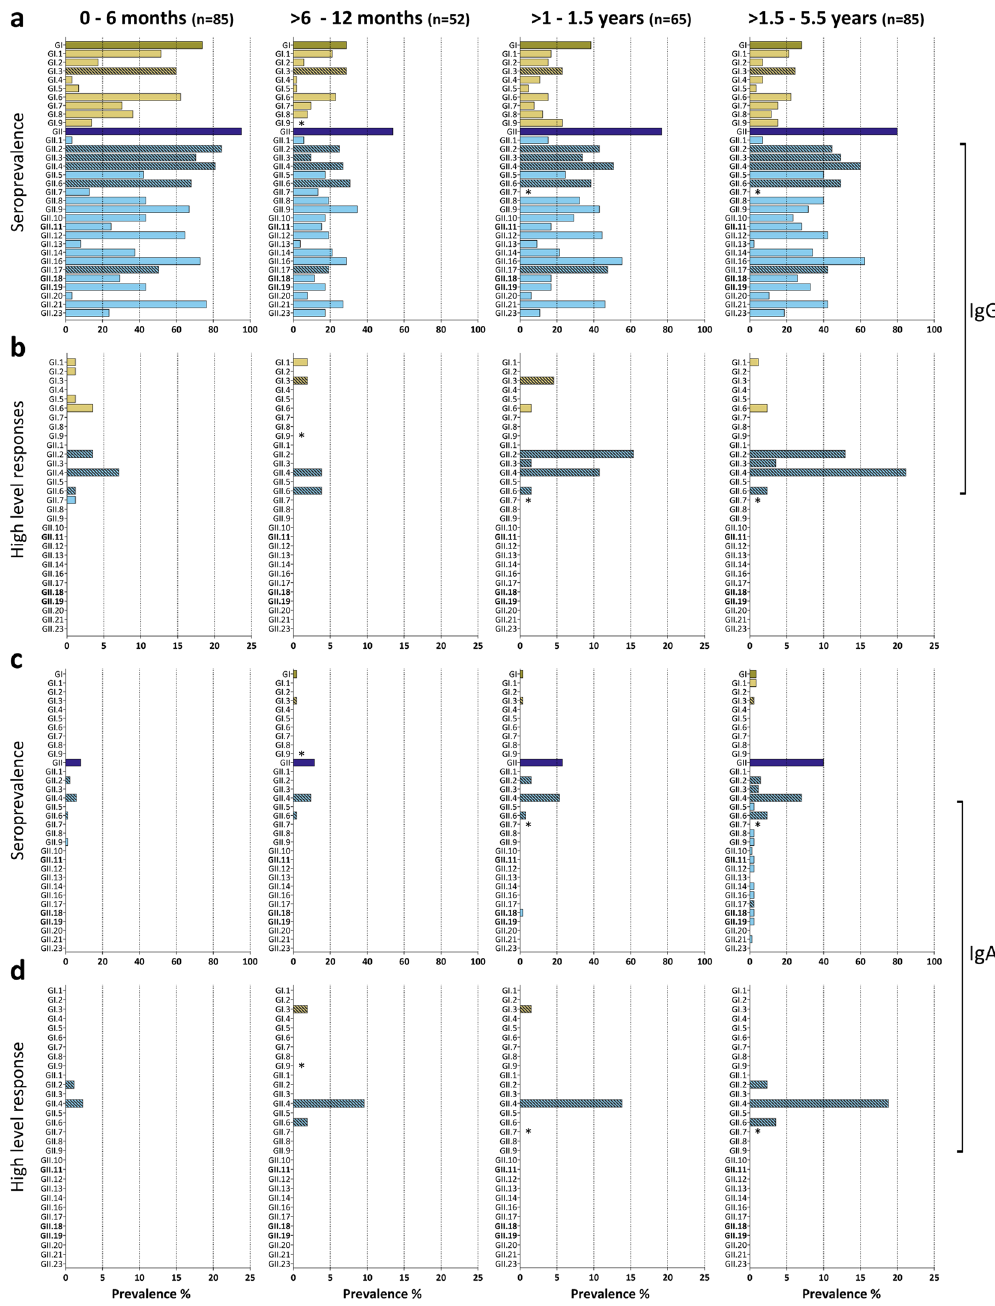
Figure 1. Genotype and genogroup-specific IgG and IgA responses. (a) IgG and (c) IgA seroprevalence in four age groups against norovirus P particles representing the human norovirus diversity. The total seroprevalence for GI and GII is also shown (dark bars). Sera with an antibody titer > 40 were considered positive. (b) IgG and (d) IgA immunodominant response sera were defined as having an antibody response against one P particle ≥ 4-fold higher than against the other genotypes. The genotypes most commonly reported in NoroNet during outbreaks are marked with a pattern. *Marks antigens that were not spotted. In bold are the porcine